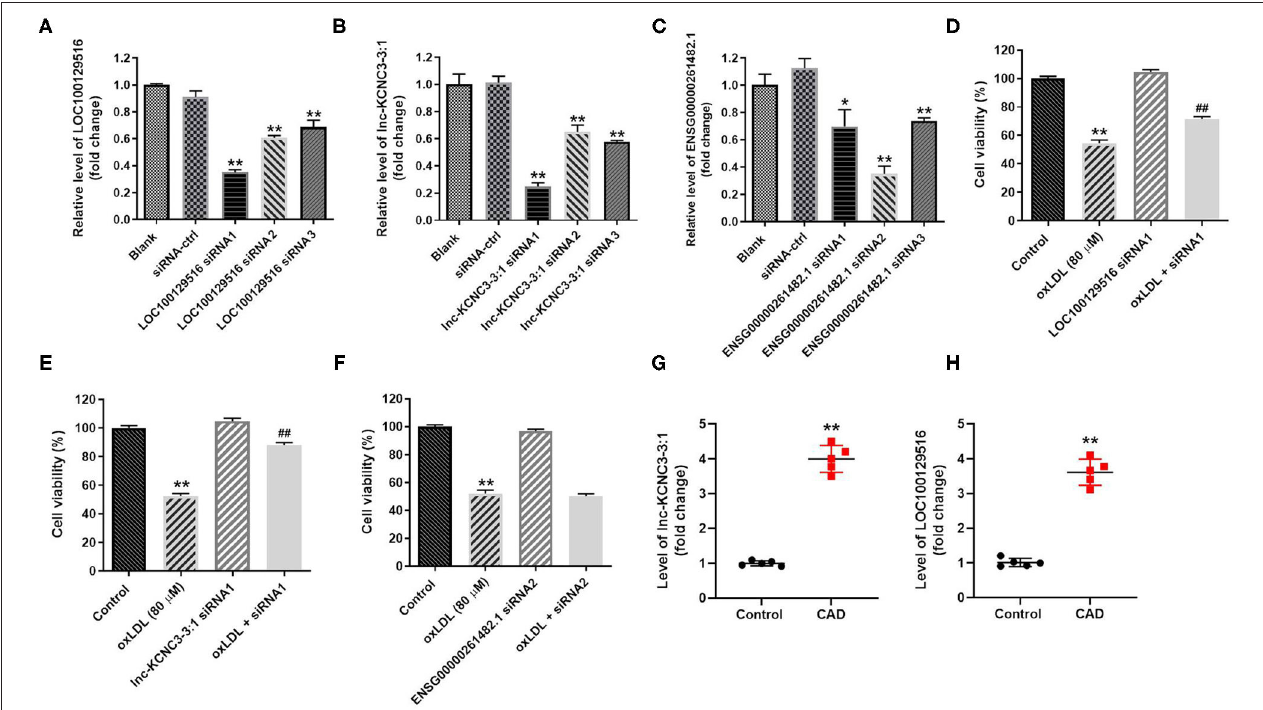
FIGURE 3 | Knockdown of LOC100129516 or lnc-KCNC3-3:1 significantly reversed oxLDL-induced growth inhibition of HUVEC. (A–C) HUVEC cells were treated with 80 µ g/mL of oxLDL for 24h. The HUVEC cells were transfected with LOC100129516 siRNA1, LOC100129516 siRNA2, LOC100129516 siRNA3; lnc-KCNC3-3:1 siRNA1, lnc-KCNC3-3:1 siRNA2, lnc-KCNC3-3:1 siRNA3; ENSG00000261482.1 siRNA1, ENSG00000261482.1 siRNA2, ENSG00000261482.1 siRNA3 or siRNA-ctrl. The level of LOC100129516, lnc-KCNC3-3:1 or ENSG00000261482.1 in HUVEC cells was detected by RT-qPCR respectively. (D–F) The HUVEC cells were transfected with LOC100129516 siRNA1, lnc-KCNC3-3:1 siRNA1 or ENSG00000261482.1 siRNA1. CCK-8 assay was used to detect the viability of HUVEC cells. (G,H) The plasma samples from five patients with CAD and five healthy donators in the First Affiliated Hospital of Jinzhou Medical University were collected. The levels of lnc-KCNC3-3:1 and LOC100129516 in the plasma of a patient with CAD and healthy people was detected by RT-qPCR respectively. * P < 0.05; ** P < 0.01 compared with control group. ## P < 0.01 compared with the oxLDL (80 µ M) group, n =